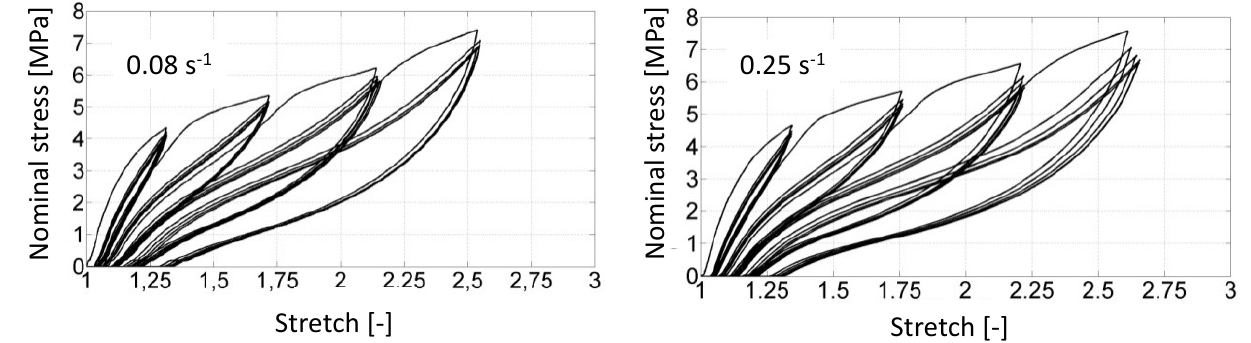
0.08 s − 1 (on the left hand side) and ±